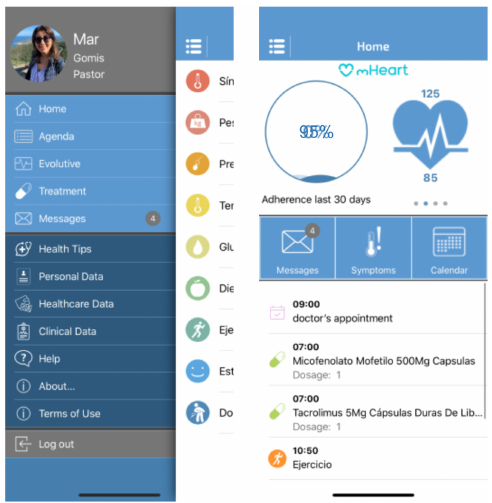
Figure 1. The mHeart mobile application main screen captures. The different app modules are displayed: Treatment, Agenda, Self-reliance, Symptoms, Messaging, Health Education and Advice, Personal and Clinical Data. The platform details have been published in the pilot study [34], a summary is also provided in Supplementary File